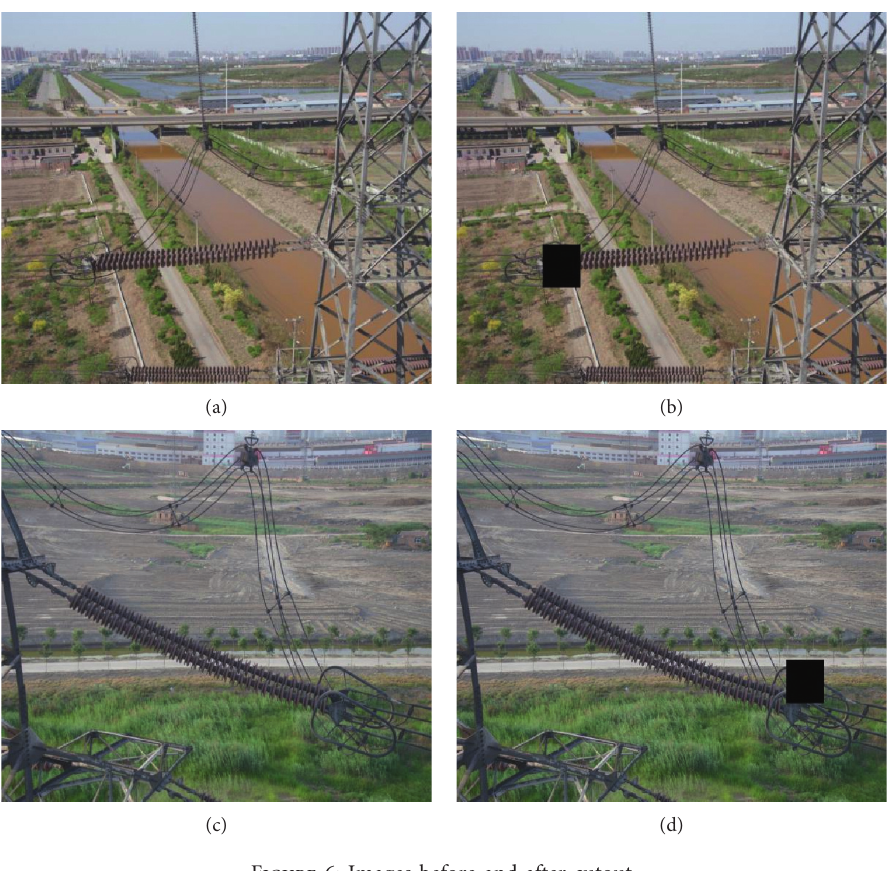
Figure 6: Images before and after cutout.